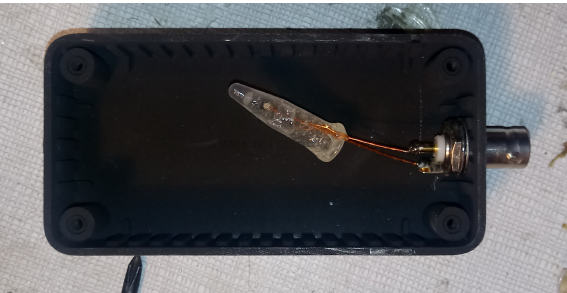
Figure 10. The detector inside the boron plastic box (the first